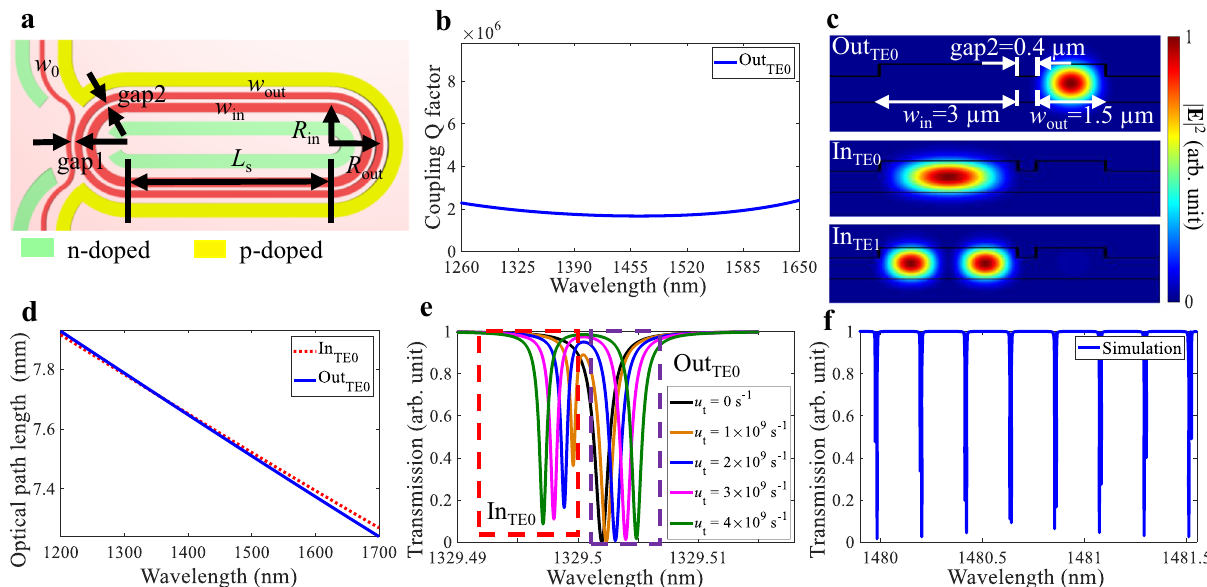
Fig. 1 The concentric racetrack resonator design. a Structure of the concentric racetrack resonator with a p-i-n junction to remove the free carriers. Schematic from the top view with geometric parameters. w 0 : 0.88 µ m; w in : 3 µ m; w out : 1.5 µ m; gap1: 0.4 µ m; gap2: 0.4 µ m; R out : 200 µ m; L s : 690 µ m. b Simulated coupling Q factors versus wavelengths from 1200 to 1700 nm. c Simulated mode propagates mainly in the outer racetrack, and modes are excited in the inner racetrack. The color bar indicates the intensity of the electric fi eld | E |. d Calculated optical path lengths at the fundamental transverse electric (TE0) modes of the outer and the inner racetracks. e Simulated transmission spectra around 1329.5 nm with different coupling coef fi cients u t between the inner and outer racetracks. f Simulated transmission spectrum of the multimode concentric resonator from 1480 to 1481.5